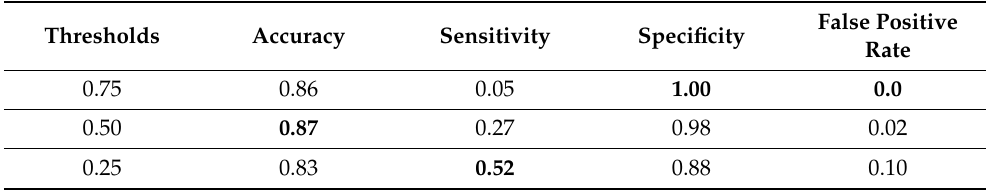
Table 5. Model accuracy, sensitivity, specificity, and false positive rate for predicting delayed mortality at three thresholds for the delayed mortality logistic regression by bark thickness (Vsp), % crown scorch, median ten-year PDSI, % moderate/severe ground char, and tree species (Canyon Live Oak as reference). Bold indicates best score for each